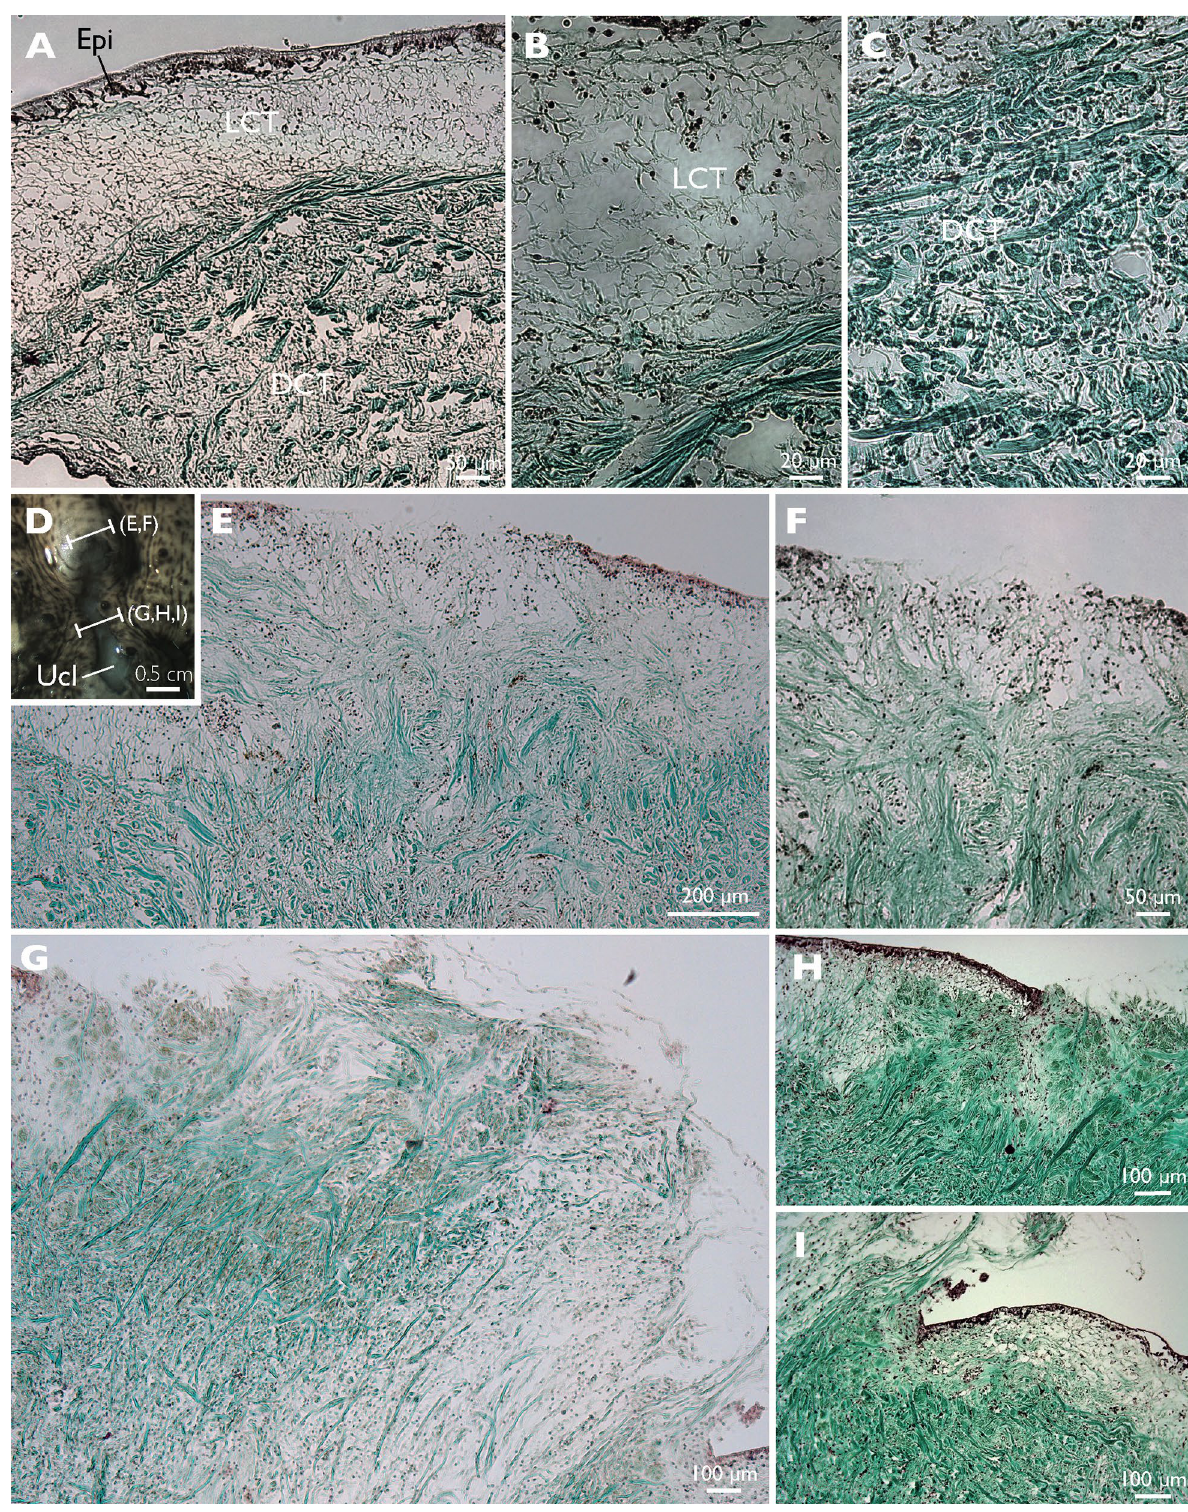
Figure 4. Histology of healthy and SKUD-affected Holothuria scabra sea cucumber integuments. ( A – C ), ( E – I ) Masson’s Trichrome staining. ( A – C ) healthy integument, ( D – I ) SKUD-affected integument. Legend: Epi epidermis, LCT loose connective tissue, DCT dense connective tissue, Ucl